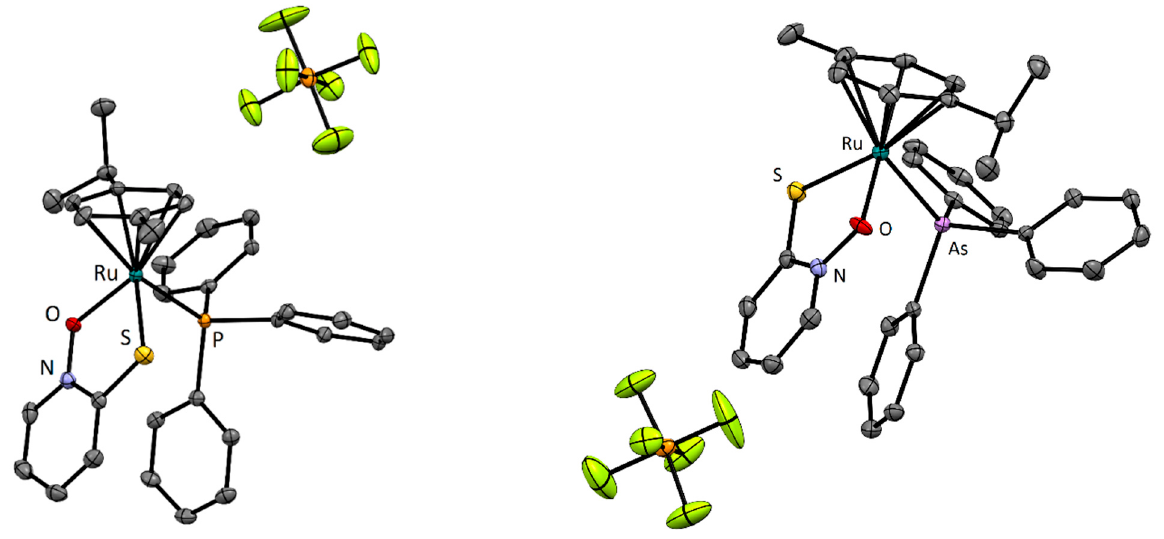
Figure 4. Crystal structures of complexes 6 ( left ) and 8 ( right ). Thermal ellipsoids were drawn at 35% probability level, and hydrogen atoms were omitted. Table 1. Selected bond lengths in ruthenium–pyrithionato complexes (Å).